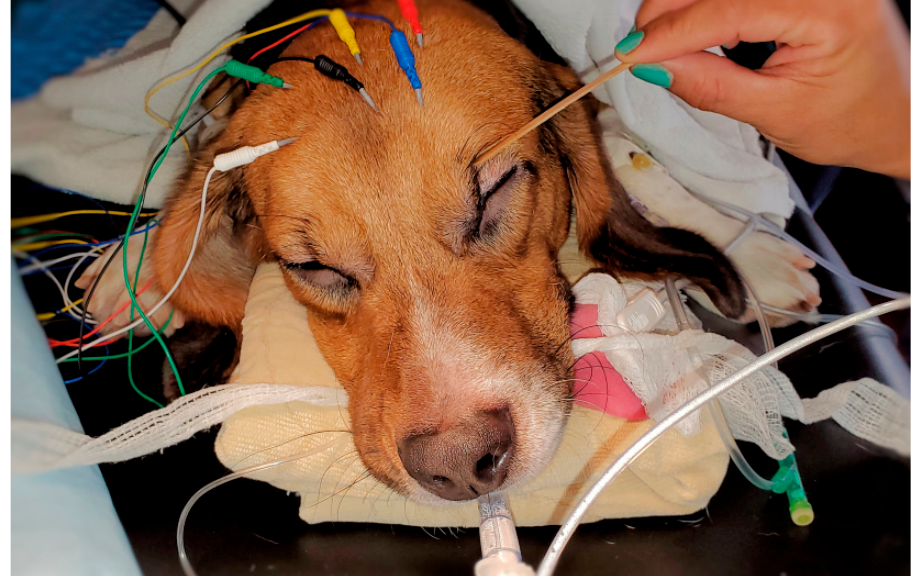
Figure 1. The image shows the position of the color-coded needle EEG leads used in this study. The electrode R1 (white color) was positioned at the Fp2 in the human 10–20 EEG system. The R2 lead (green color) was positioned between F4 and F8 location. The L1 (blue color) lead was positioned at the Fp1 location, and the L2 lead (red color) was positioned between F3 and F7 location. The ground (CB, yellow color) and the reference (CT, black color) electrodes were placed on the mid-sagittal line in the central and the cranial position, respectively. The image also shows the use of a cotton swab for assessing the dog’s eye reflexes (palpebral and globe position).